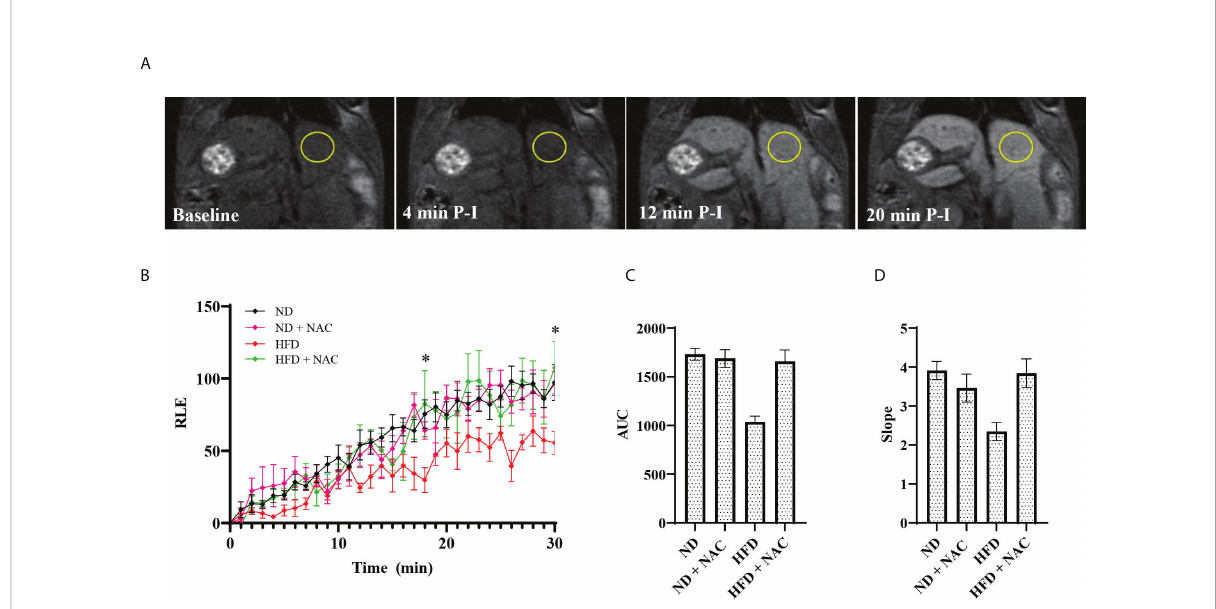
FIGURE 1 Effects of HFD on liver function as assessed by DCE-MRI with the contrast agent Gadoxetate Disodium (Eovist ® Bayer). (A) Representative images of 26-30 week old male mice undergoing DCE-MRI, showing T1-weighted images performed before Eovist ® injection and at 4, 12 and 20 minutes post-injection (P-I). The yellow circle denotes a typical region of interest used to measure mean intensity. (B) Time course of relative liver enhanced T1 signal intensities after Eovist ® injection, comparing mice on ND (n=4), ND + NAC (n=5), HFD (n=5), and HFD + NAC (n=5). The differences in mean intensity between HFD and all the other groups (ND, ND + NAC and, HFD + NAC) were signi fi cant at 18- and 30-minutes post-injection. (C) Area under the curve (AUC) calculated from the data in (B) . (D) The slope of T1 signal intensity increase for each group shown, corresponding to the rates of change within the fi rst 20 min after Eovist ® injection. Statistical signi fi cance was established using a one-way ANOVA multiple comparisons test. “ * ” 0.05 to